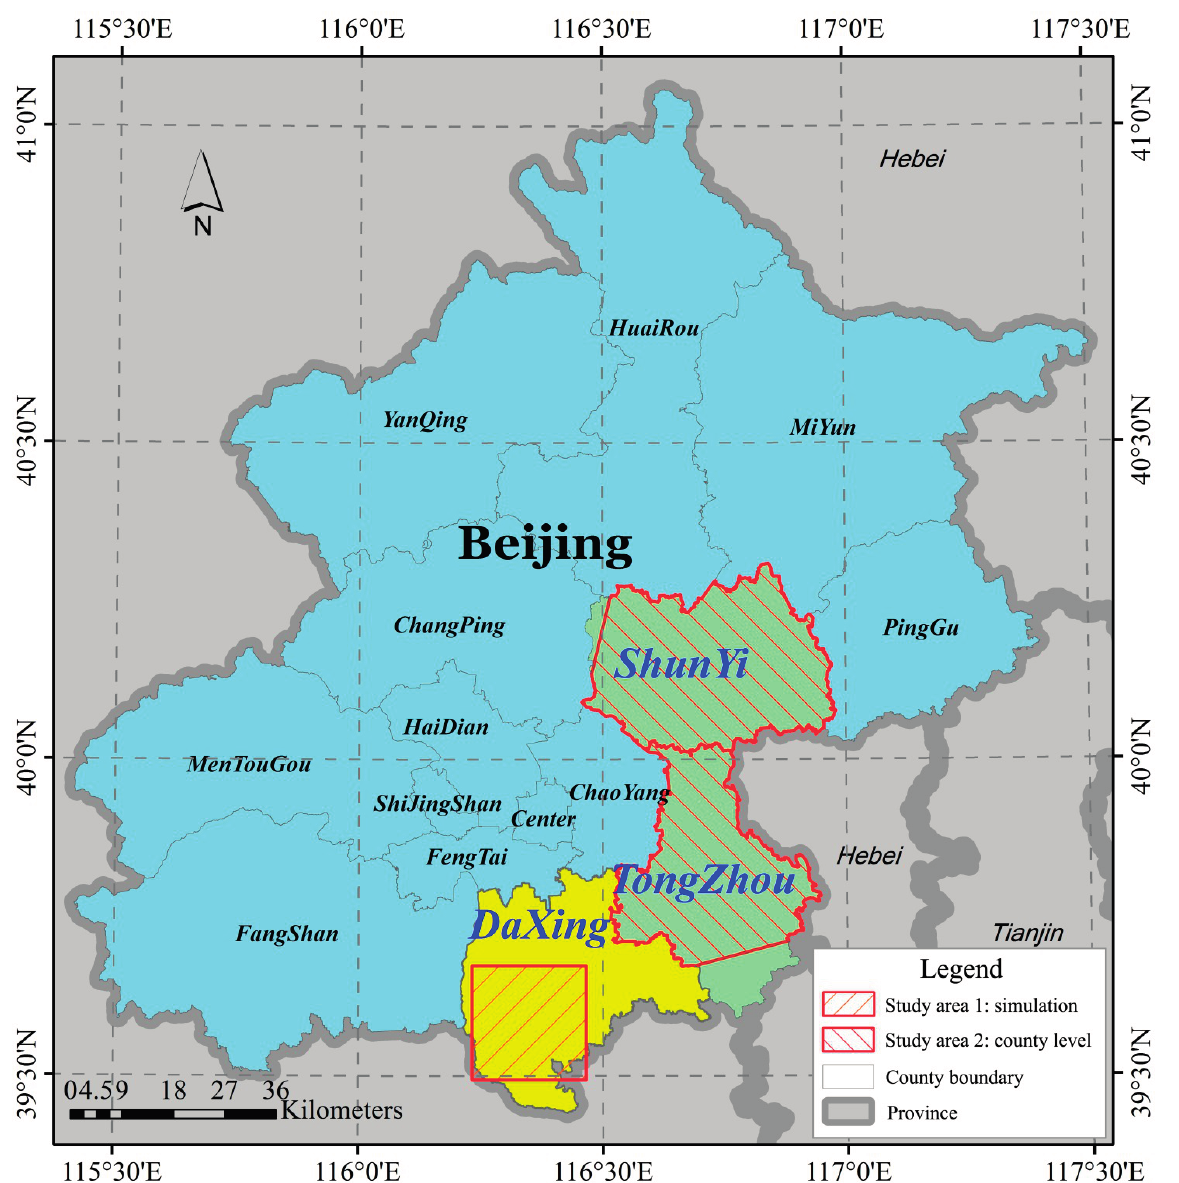
Figure 1. Location of study area for the simulated experiment and case